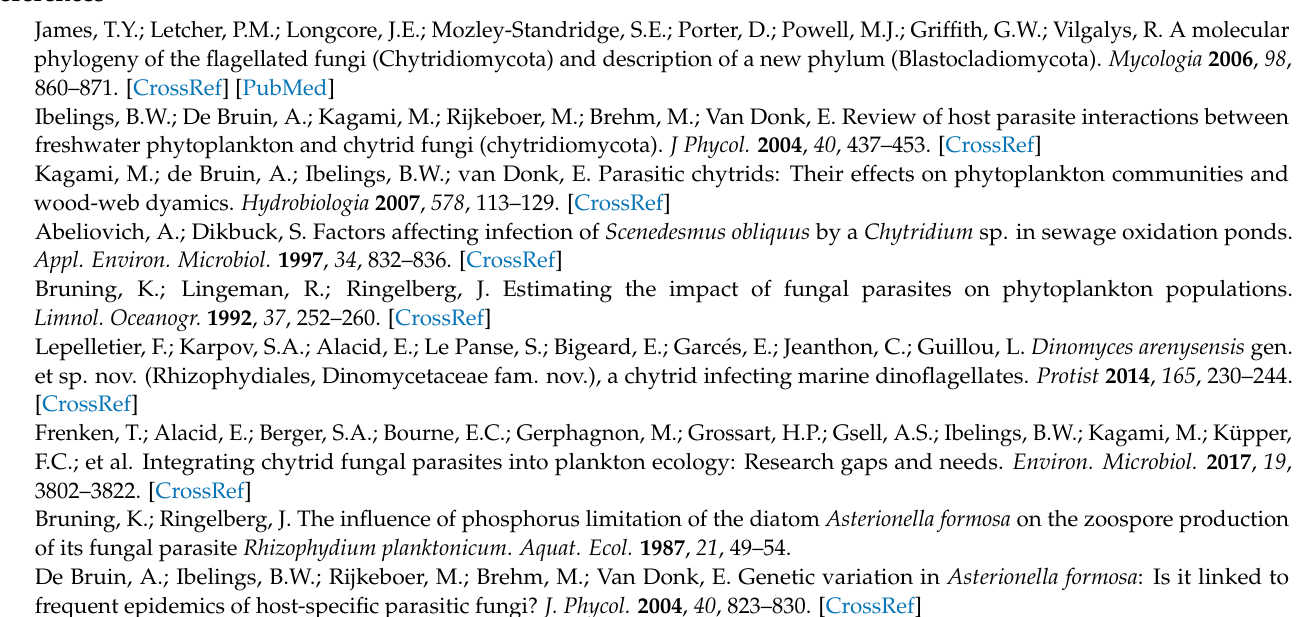
Table S2: Inoculation details, Table S3: Resume of Generalized Linear Model